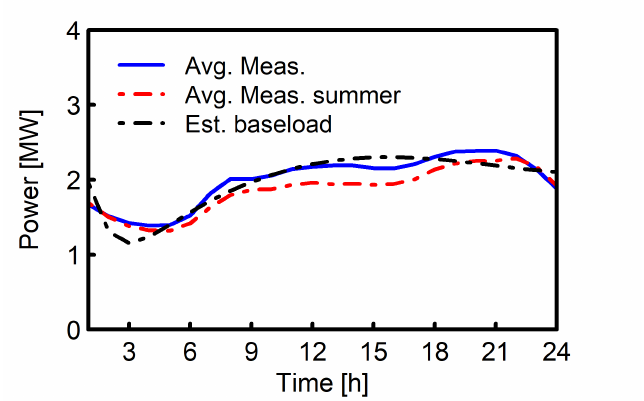
Figure 13. Baseload hourly profiles for summer days estimated with the proposed method and based on the experimental total load at approx. 18 ◦ C considering data for May to August (Avg. Meas. summer) and for all months (Avg. Meas.) during